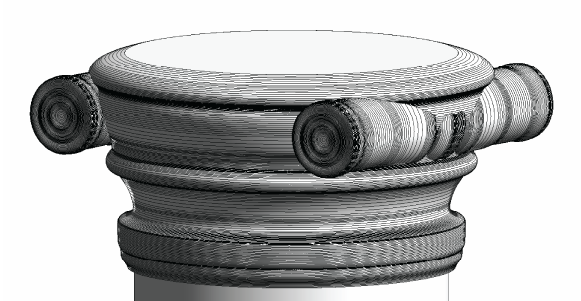
Figure 9. Parametric model of the capital generated by the profiles obtained from the dense point cloud